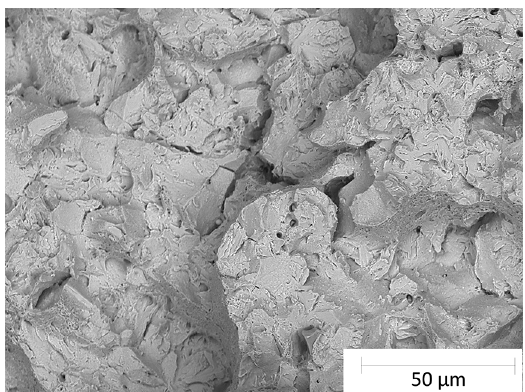
Figure 13. SEM/BSE image of fracture surface from CVN mid- thickness specimen from sample S